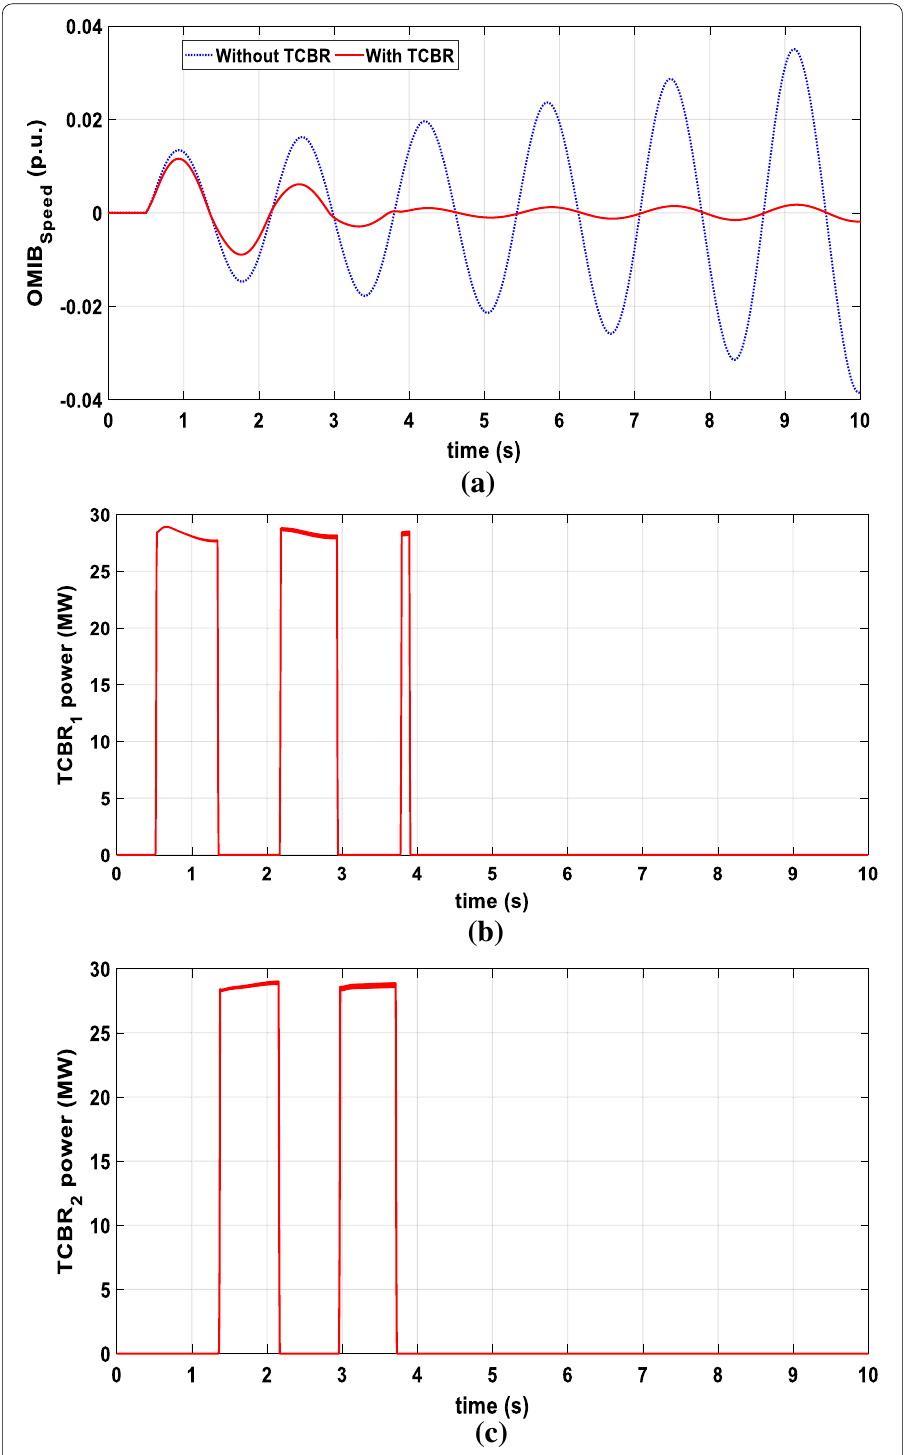
Fig. 10 Case (2) OMIB Speed and TCBR dissipated power responses, a OMIB Speed , b TCBR 1 dissipated power, c TCBR 2 dissipated